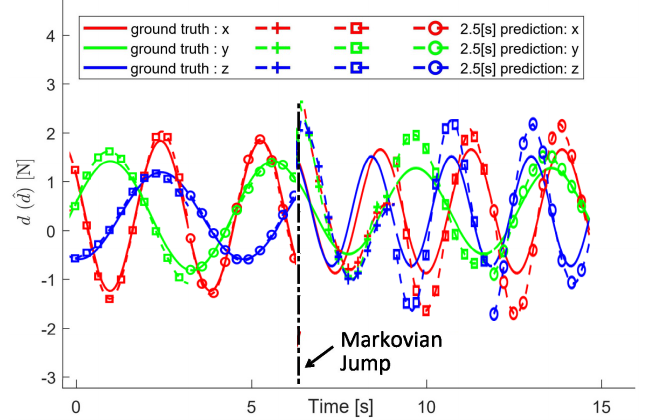
Figure 5. Disturbance prediction example by DOB–net. Solid curves showing ground truth; marked curves showing 2.5 (s) prediction from three different